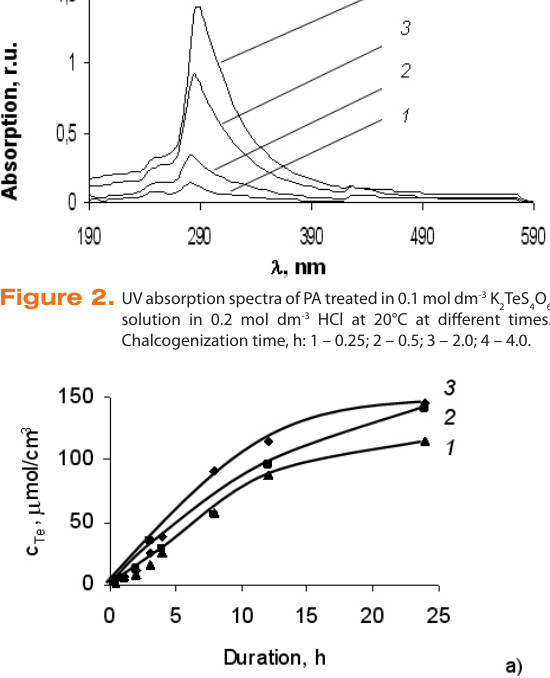
TeS O 2 4 6 solution in 0.2 mol dm -3 HCl at 20°C at different